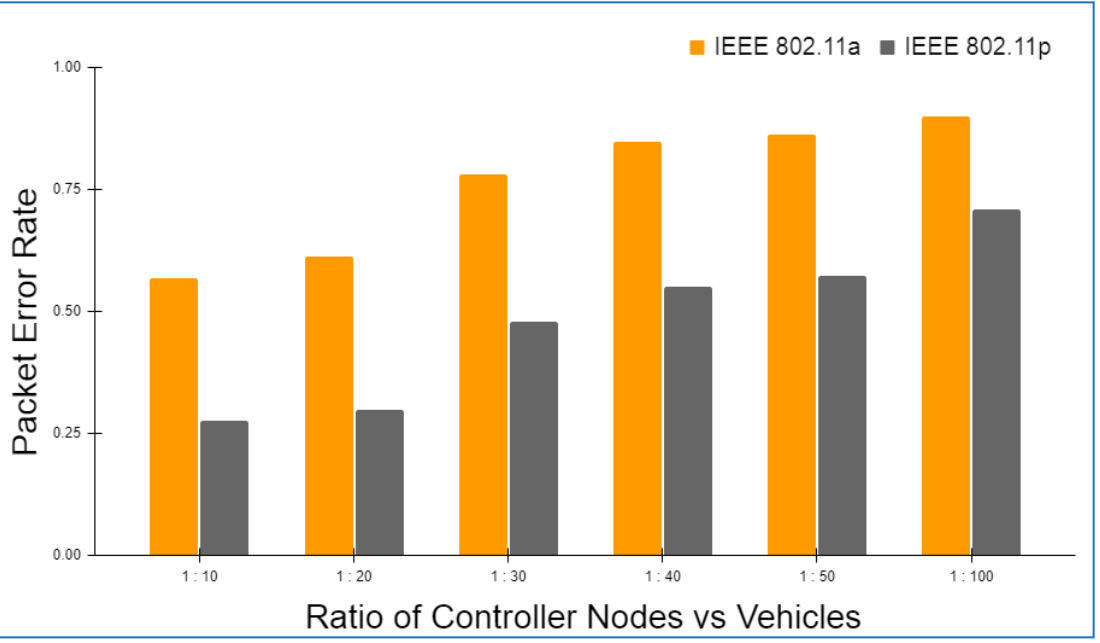
Figure 12. Packet Error Rate in the proposed framework for IEEE 802.11a vs. IEEE802.11p.